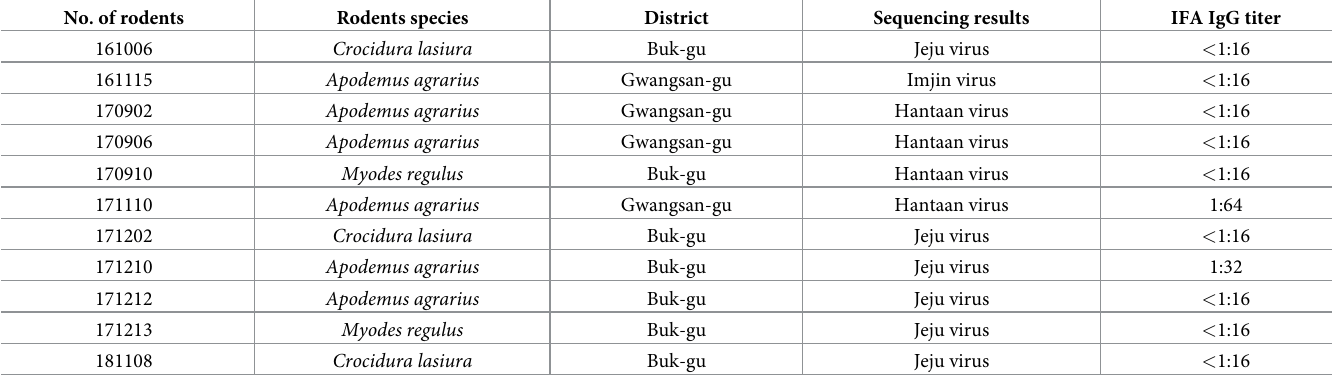
Table 4. Indirect immunofluorescence antibody (IFA) titer and sequencing results of hantavirus PCR positive rodents. No. of rodents Rodents